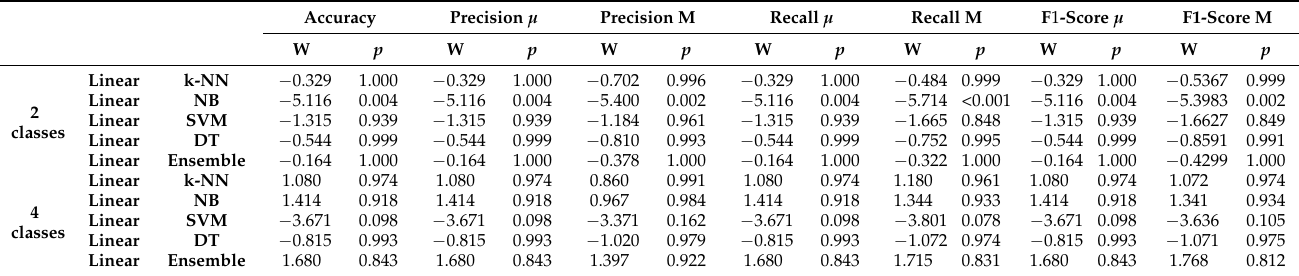
Table 6. Dwass–Steel–Critchlow–Fligner pairwise comparisons between Linear model and each Machine Learning model using MRMR algorithm.